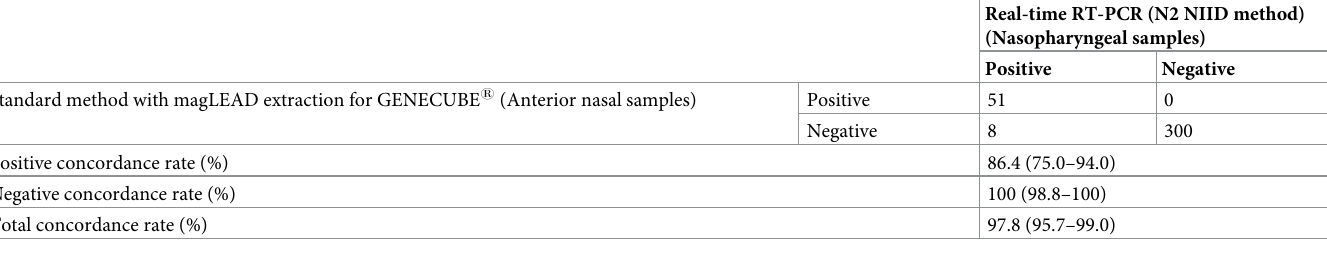
Table 6. Concordance rate between the GENECUBE 1 HQ SARS-CoV-2 with anterior nasal samples and real-time RT-PCR with nasopharyngeal samples, both of which were simultaneously obtained from suspected or confirmed COVID-19